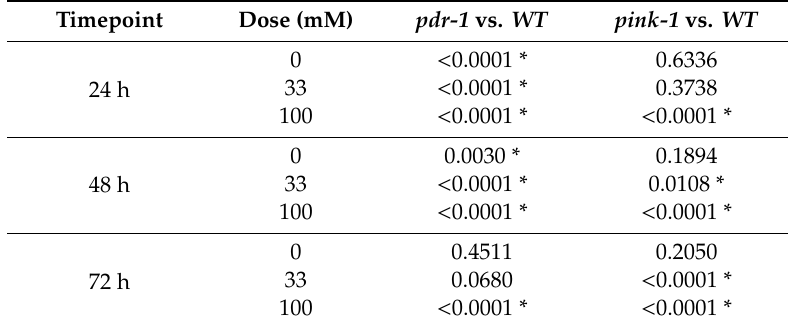
Table 4. p -values (Fisher’s exact test) for strain comparisons ( pink-1 and pdr-1 vs. WT) after 6-OHDA exposure in young adult C. elegans . Timepoint Dose (mM) pdr-1 vs. WT pink-1 vs.